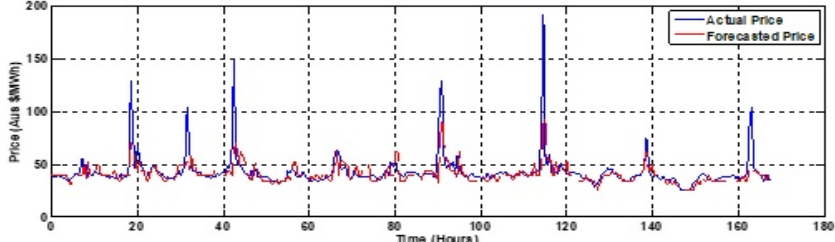
Figure 9. September 1–7, 2015 forecasting without feature selection in the spring season (MAPE = 11.70).